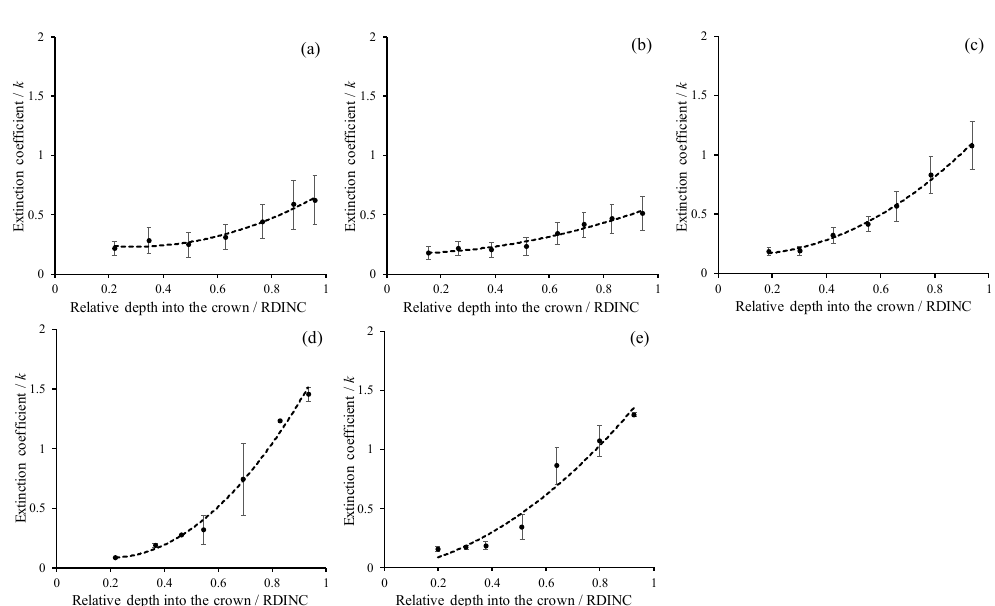
Figure 2. Vertical patterns of light transmittance (The ratio of photosynthetically active radiation in the crown to the incident photosynthetically active radiation, LT) for the planted Larix olgensis Henry trees. (a~e) represents Tree I ~ Tree V. The dark circles are the mean LT in each pseudowhorl, and the black bars are standard deviations.